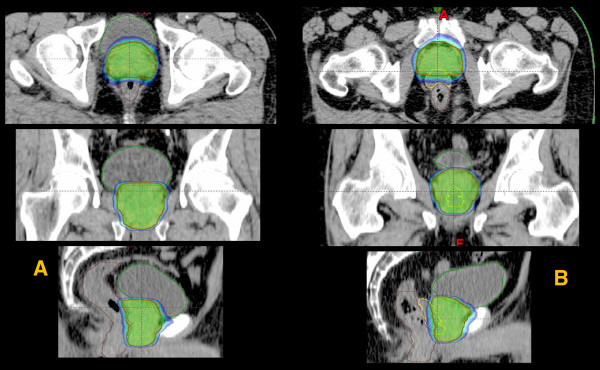
Example of dose distributions in axial, coronal and sagittal views for one patient without (A) and one patient with SpaceOar (B). Colorwash for dose scaling was set in the range 70-110%.